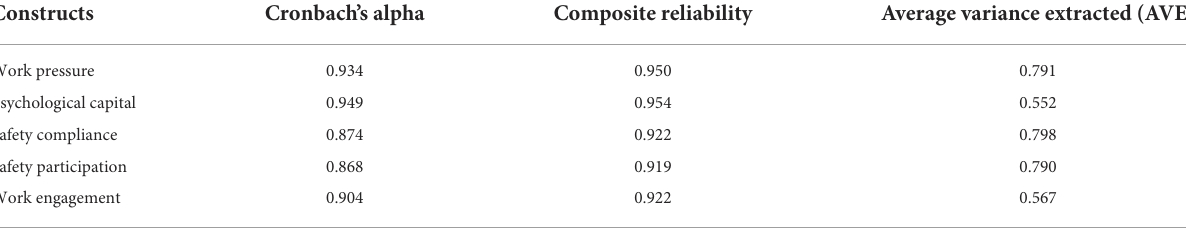
TABLE 2 Result of convergent and reliability analysis.